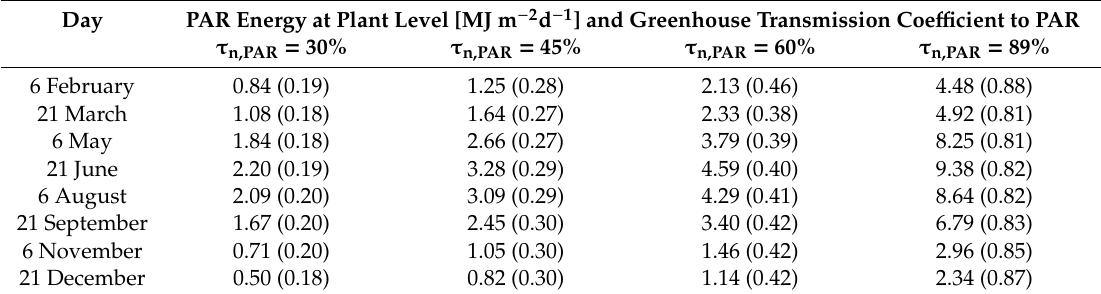
Table 9. Daily cumulative PAR solar energy at plant level and daily average greenhouse transmission to PAR (in parentheses) for the di ff erent OPV / PE combinations